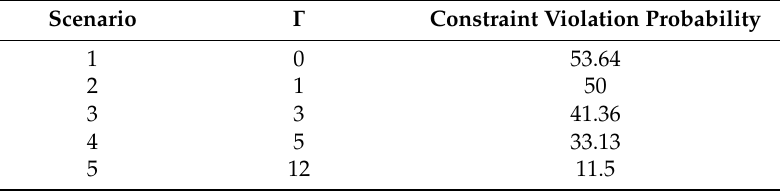
Table 3. Optimization results under different constraint violation probabilities.